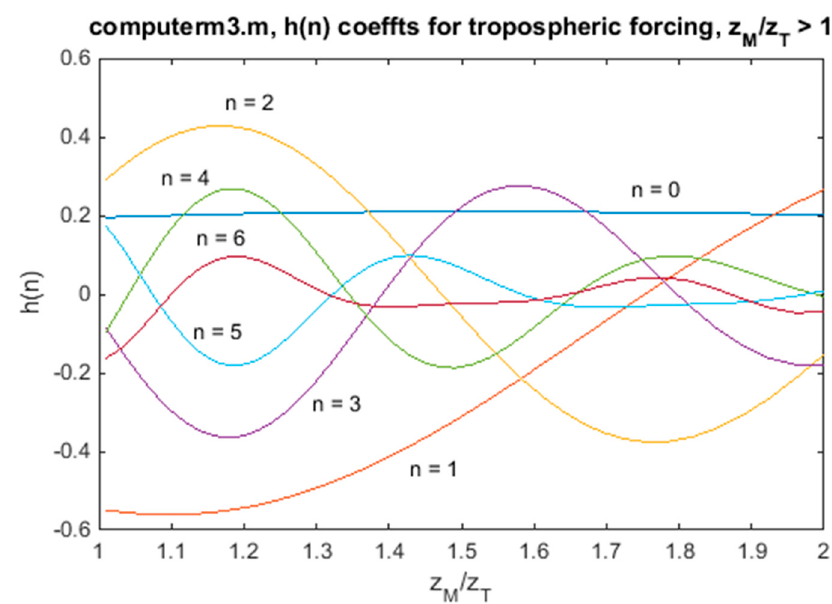
Figure A2. Values of the first six Fourier coefficients h n for forcing within the troposphere, but for eruptions that reach into the stratosphere up to levels of 2 z T . H s = 9 km. Note that modes 1 and 2 have similar magnitudes to those for z M = z T up to about z M / z T = 1.4.